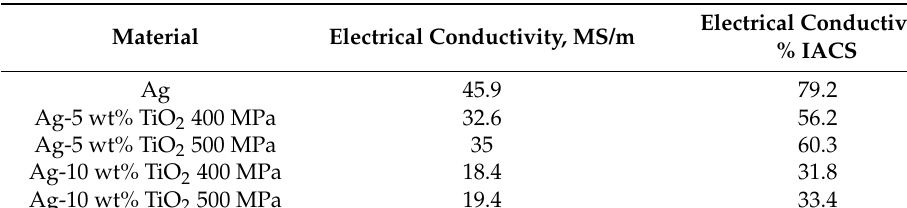
Table 1. Electrical conductivity of Ag–xTiO 2 composites.